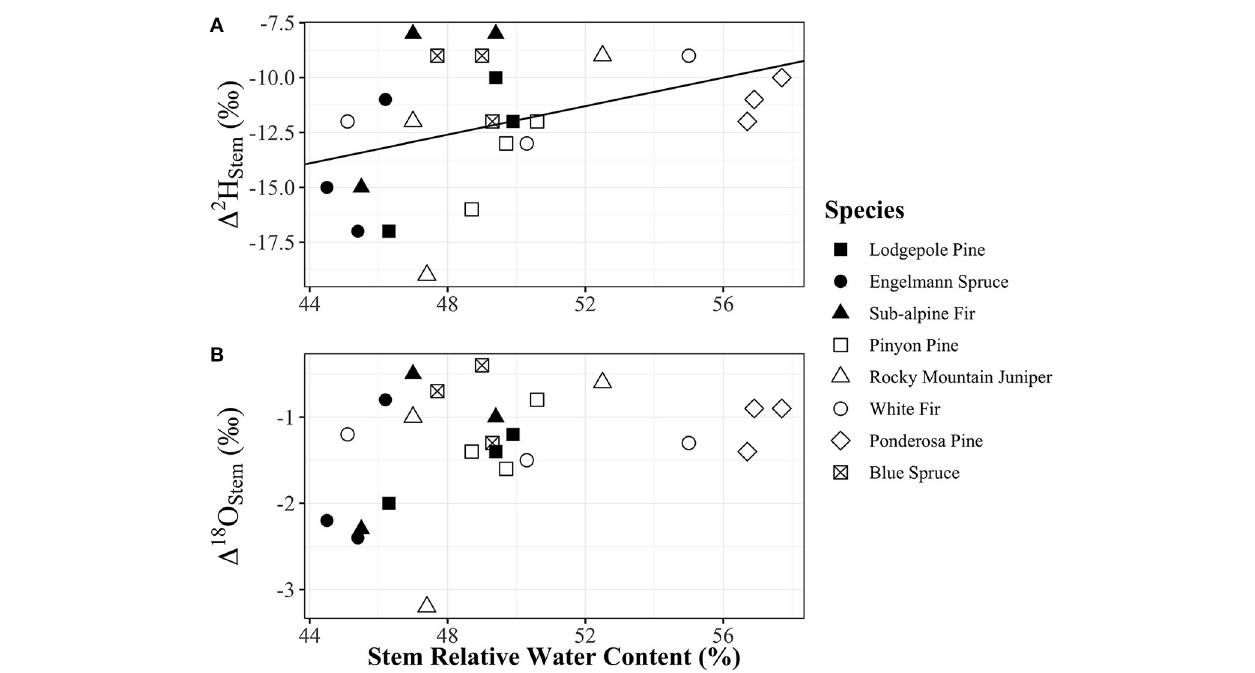
FIGURE 6 | (A) 1 2 H stem and (B) 1 18 O stem vs. relative water content of stems [(g water/g dry mass) × 100]. Relative water content of stems had a significant positive relationship with 1 2 H stem values ( y = 0.3252 x – 28.21, p = 0.048, R 2 = 0.17), but not with 1 18 O stem values ( p = 0.092) which also had a similar positive trend in data. Plot panels share the same x -axis and legend. Points shapes are different for each species with filled in point shapes from the Med Bow location and remaining point shapes from the Campus location.